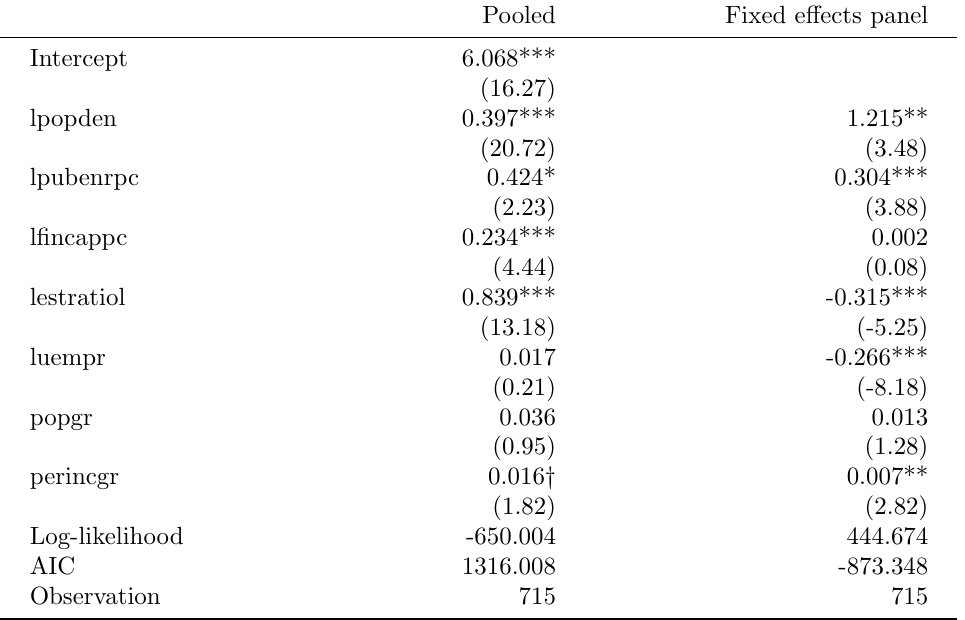
Table 2: Non-spatial regression models Pooled Fixed effects panel